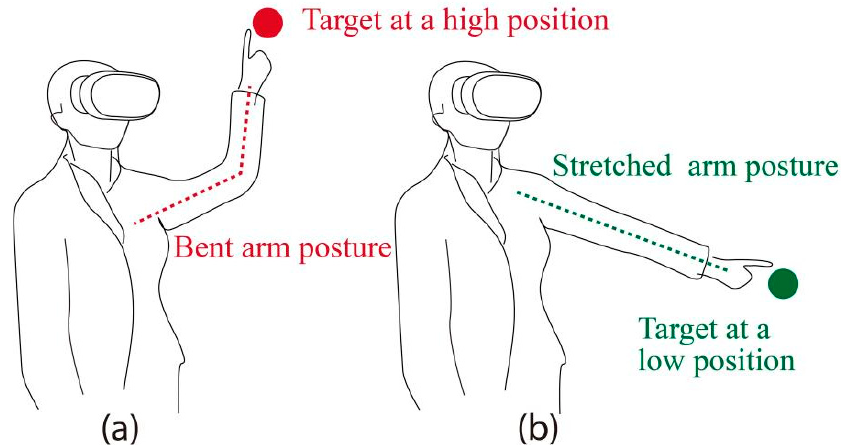
Figure 1. An example of arm postures and hand-operational positions in VR: ( a ) acquiring a target at head height through an upraised bent arm posture; ( b ) acquiring a target at waist height through a downward-stretched arm posture.